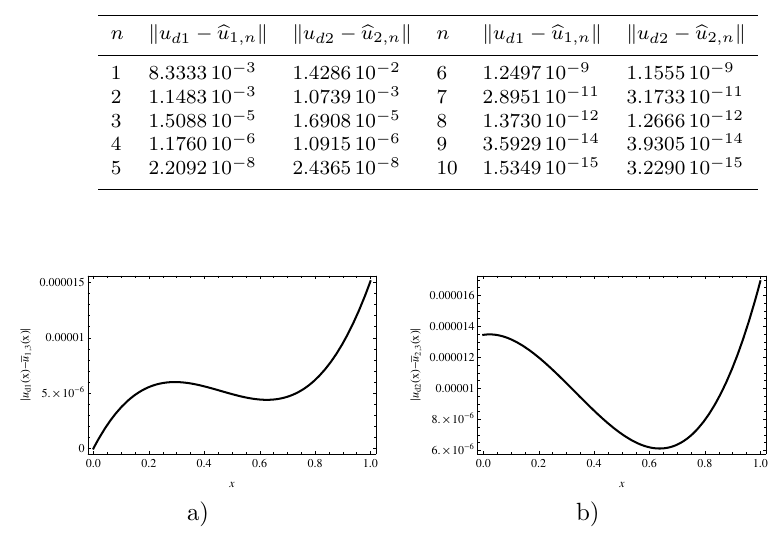
Figure 3. Distribution of error of the exact solution approximation for n =